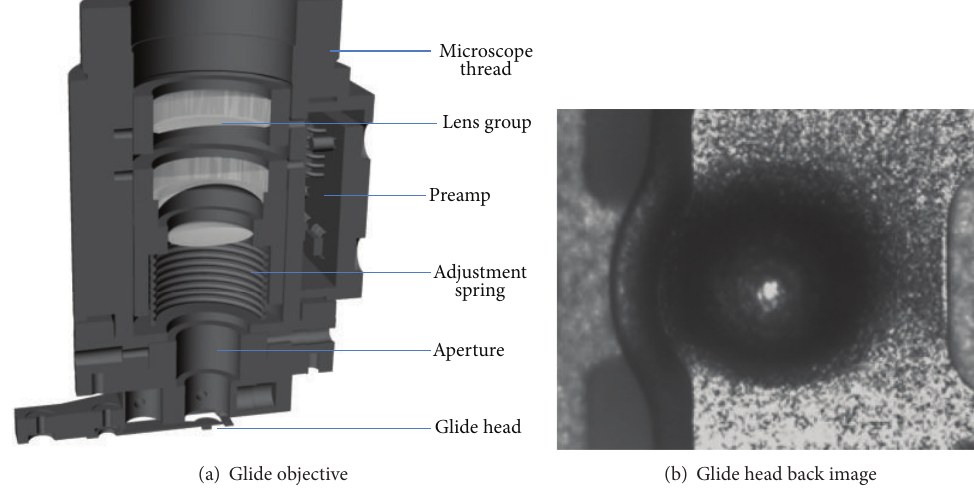
Figure 6: Glide objective illustration. (a) shows the internal construction of the glide objective with a 5x lens group enables the imaging on the back of the glide head. An adjustable spring enables the fine focus on the glide head. The preamplifier is integrated to the glide objective to achieve short wire length to the glide sensor. (b) The image of the back of the glide head. In the field of the view, only the center part of the glide head is visible, showing the dimple of the suspension HGA. Glide head position is calibrated against the dimple position.